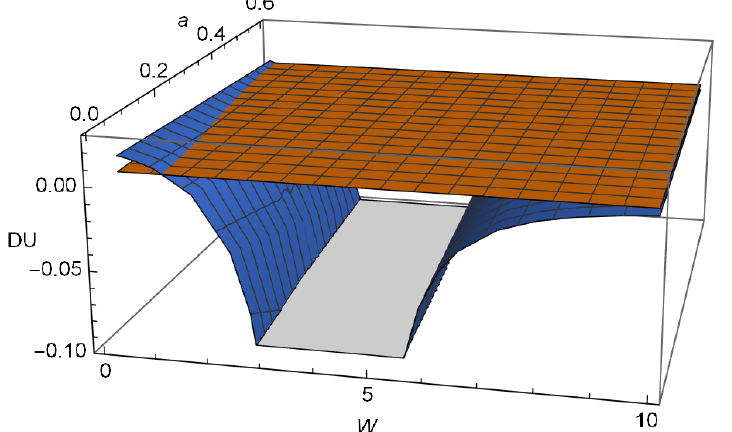
Figure 10. DU ( W , a ) δ = 1 for a ∈ ( 0,0.70347 )